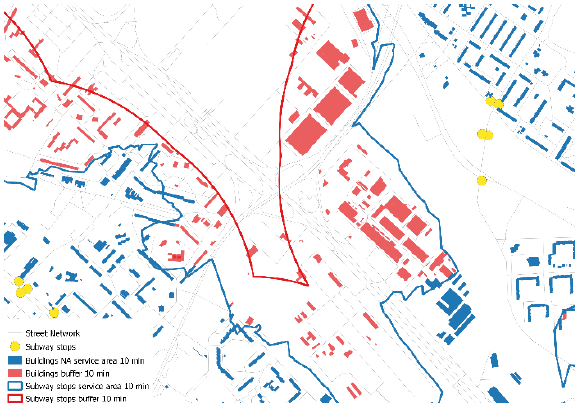
Figure 10. Comparison of accuracy of included buildings in the isochrone impedance in Buffer and Network Analysis